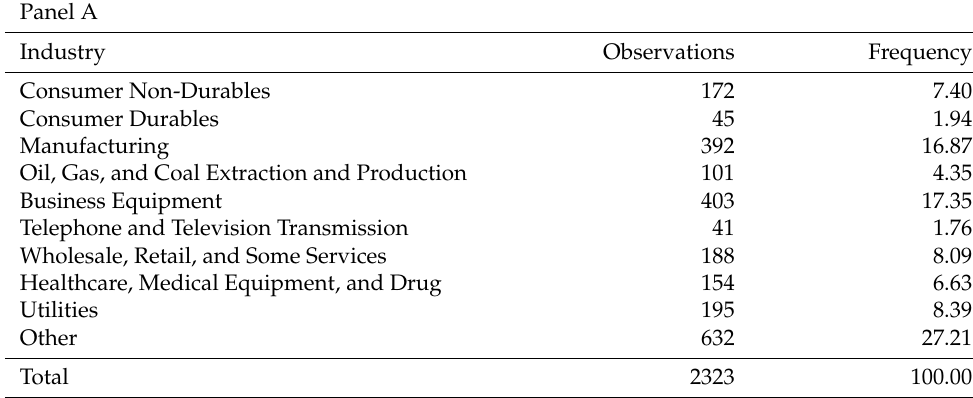
Table 1. Panel A, sample distribution by industry; Panel B, sample distribution by